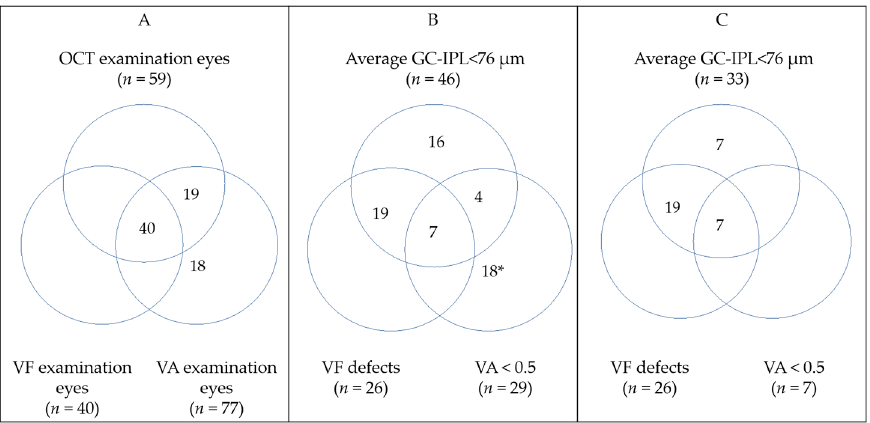
Figure 4. Venn diagrams illustrating: ( A ) All eyes with optic pathway glioma (OPG) that underwent any ophthalmological examination; ( B ) all eyes with OPG that had any abnormal ophthalmological finding; ( C ) eyes with OPG that underwent all ophthalmological examinations and had pathological findings. Detailed information about clinical finding may be found in Table S1. * None of those eyes provided OCT data (14 blind). GC-IPL—ganglion cell + inner plexiform layer; VA—visual acuity; VF—visual field.